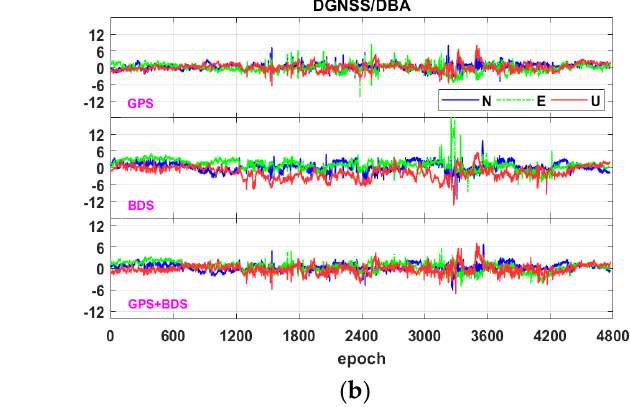
Figure 15. The deviation sequence diagram in the N/E/U directions during the kinematic vehicle experiment in the open urban environment: ( a ) DGNSS positioning mode; ( b ) DGNSS/DBA positioning mode.